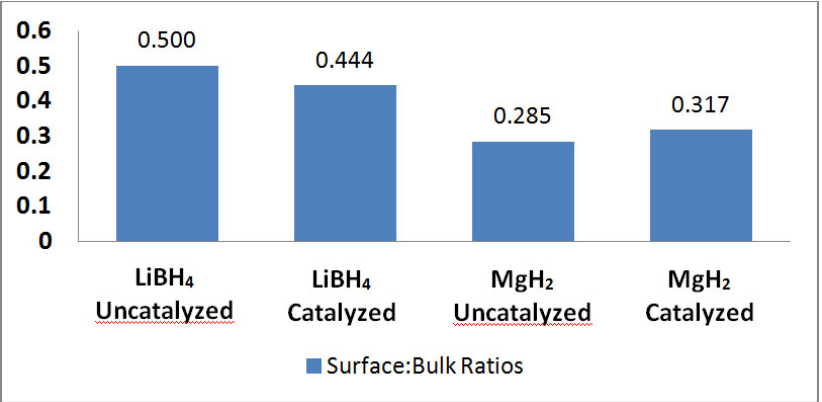
Figure 6. Comparison of interfacial boundary volume for LiBH (uncatalyzed), and MgH (catalyzed). The LiBH (catalyzed), MgH 2 2 particles ( i.e. higher interface volume to bulk volume ratios) than the MgH significant trend in interfacial volume for catalyzed and uncatalyzed samples is noted in or MgH either the case of pure LiBH 4 2